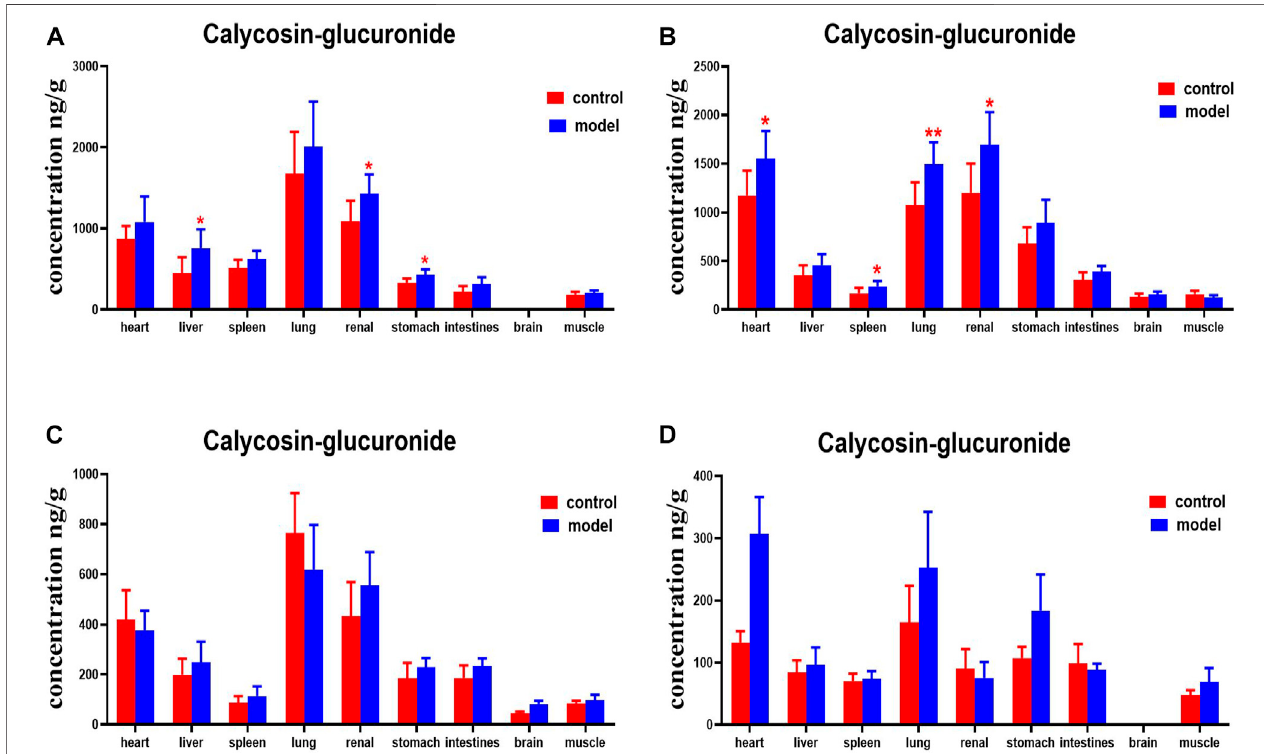
FIGURE 12 | Content of calycosin-glucoside in different mouse tissue homogenate of the normal and DN models at four different time points after intragastric administration of HQD (x±SD, n =8), (A) 30 min, (B) 2 h, (C) 4 h, (D) 8 h. Ps: * P < 0.05, ** P < 0.01 vs. normal group.